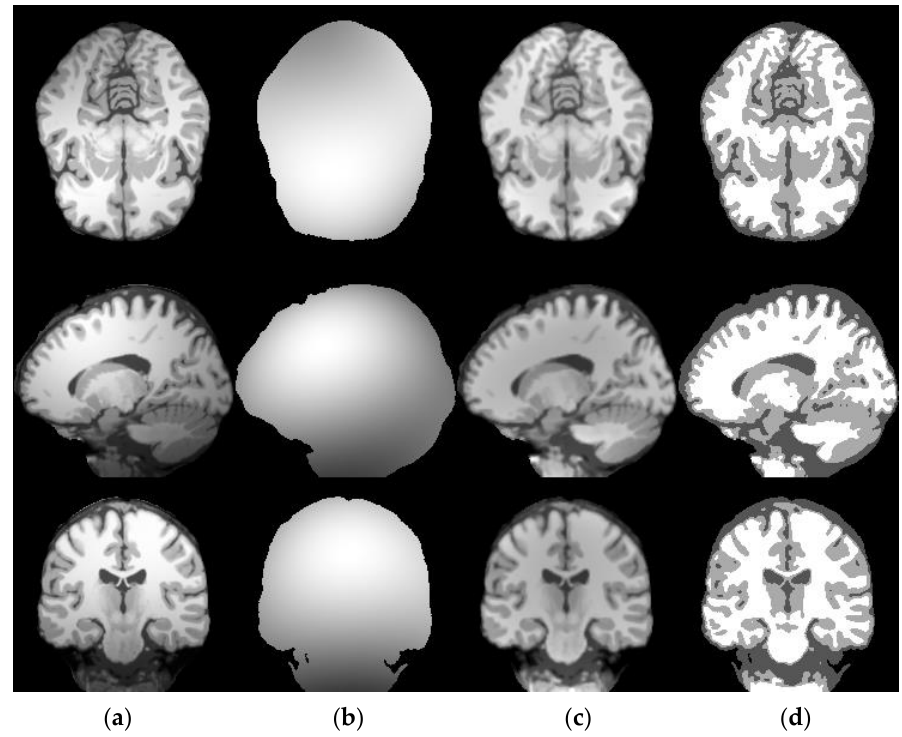
Figure 5. Segmentation results of inhomogeneous intensity brain MRI: ( a ) original images; ( b ) estimated bias field; ( c ) bias field correction images; and ( d ) segmentation results.